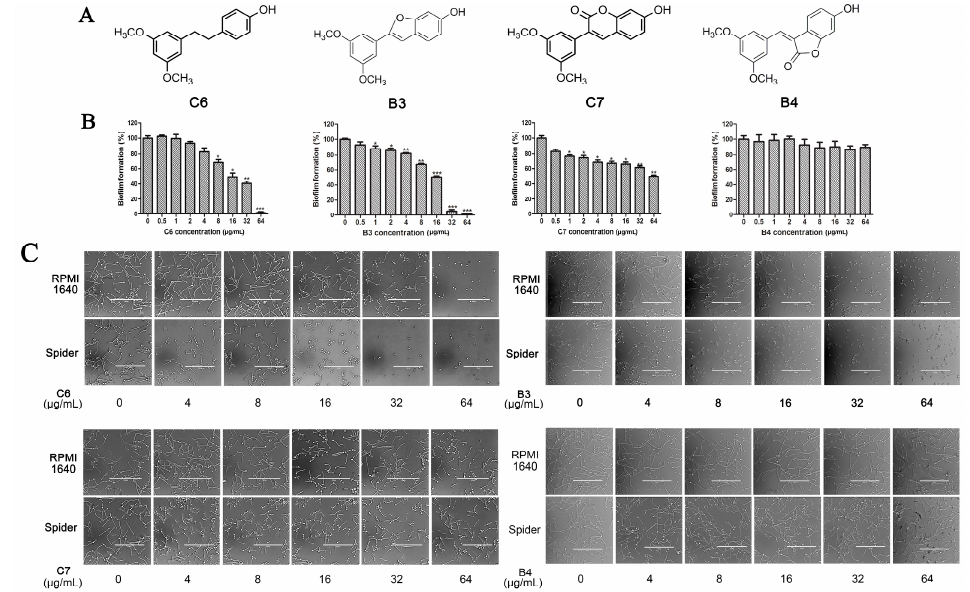
Figure 4. Effects of different concentrations of analogues C6, B3, C7, and B4 on biofilm formation and hyphal formation. ( A ) Chemical structures of analogues C6, B3, C7 and B4 are shown. C6, B3, C7, and B4 are both different from PTE in partition B; ( B ) Effects of different concentrations of analogues C6, B3, C7, and B4 on biofilm formation. Biofilm formation results represent the mean ± standard deviation for three independent experiments. * p < 0.05 compared with the control biofilms, ** p < 0.01 compared with the control biofilms, *** p < 0.001 compared with the control biofilms. Statistical analysis was performed to compare the effects of various compounds, and significant difference was observed upon C6, C7, and B4 compared with PTE. p = 0.037 (C6 vs. PTE), p = 0.175 (B3 vs. PTE), p = 0.0033 (C7 vs. PTE), and p < 0.001 (B4 vs. PTE); ( C ) Effects of different concentrations of analogues C6, B3, C7, and B4 on hyphal formation. Scale bar = 100 μ m.